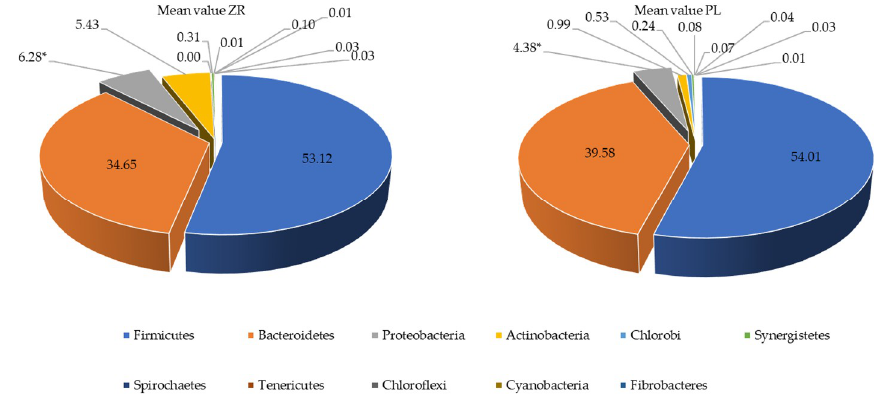
Figure 4. Relative proportions (percent) of phylum in the fecal samples of treated patients (ZR) and those of placebo (PL) patients.